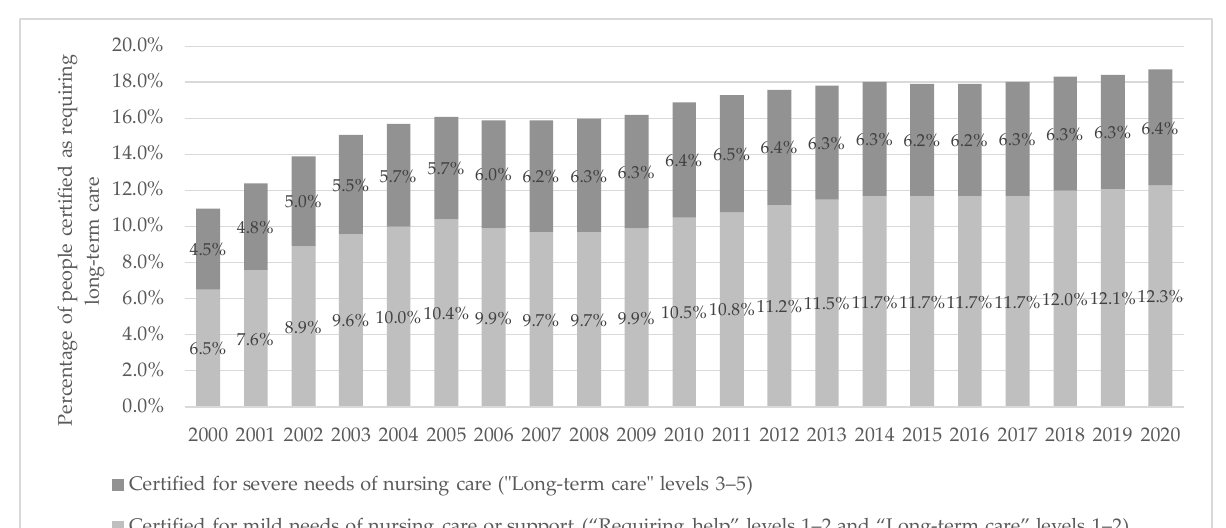
Figure 2. Percentage of people certified as requiring long-term care among older adults (2000–2020). Data source: Ministry of Health Labour and Welfare, Status report on Long-term Care Insurance (2020) [8]. Note: “Requiring help” and “Long-term care” levels 1–2 were included in the mild needs of nursing care from 2000 to